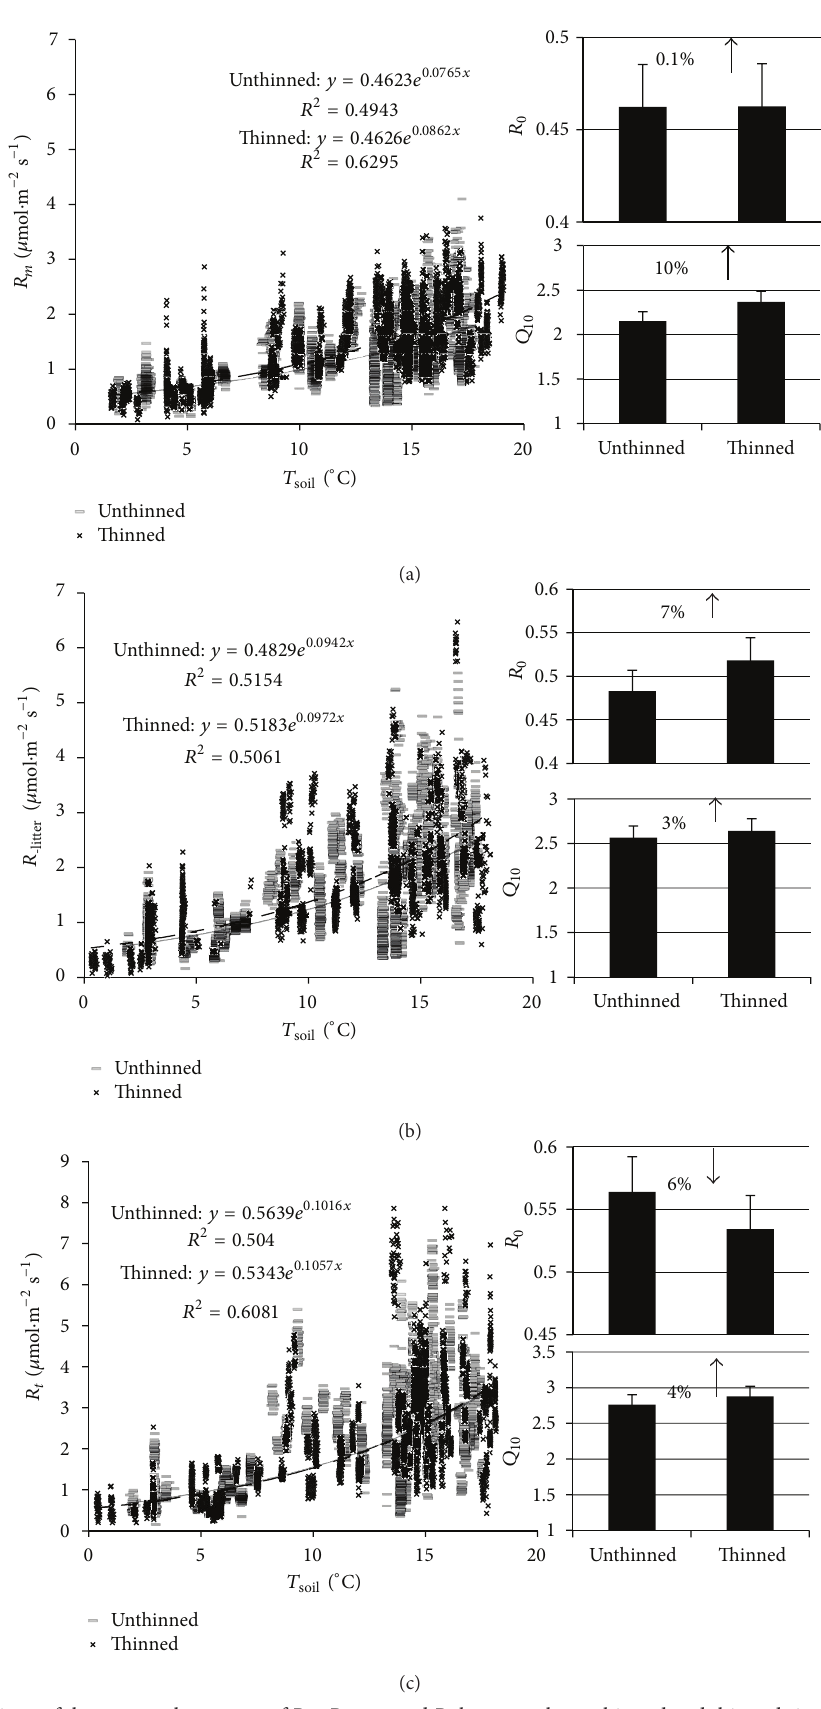
Figure 4: Comparison of the temporal response of 𝑅 𝑚 , 𝑅 −